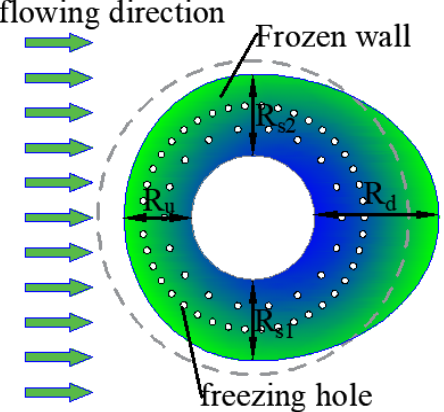
Figure 9. Effective frozen wall thickness of − 135 m fine sand layer. ( a ) Thickness of upstream and downstream; ( b ) thickness of flank.